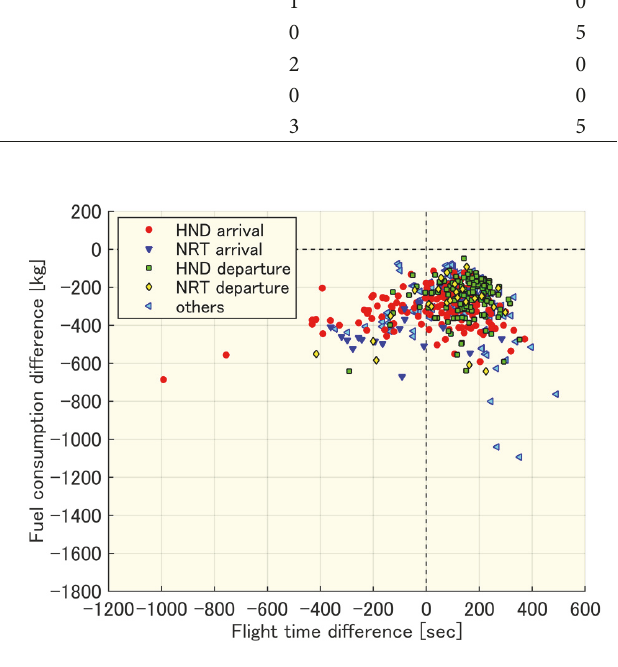
Figure 8: Fuel difference of the optimal trajectories relative to the original flights (Type-A).